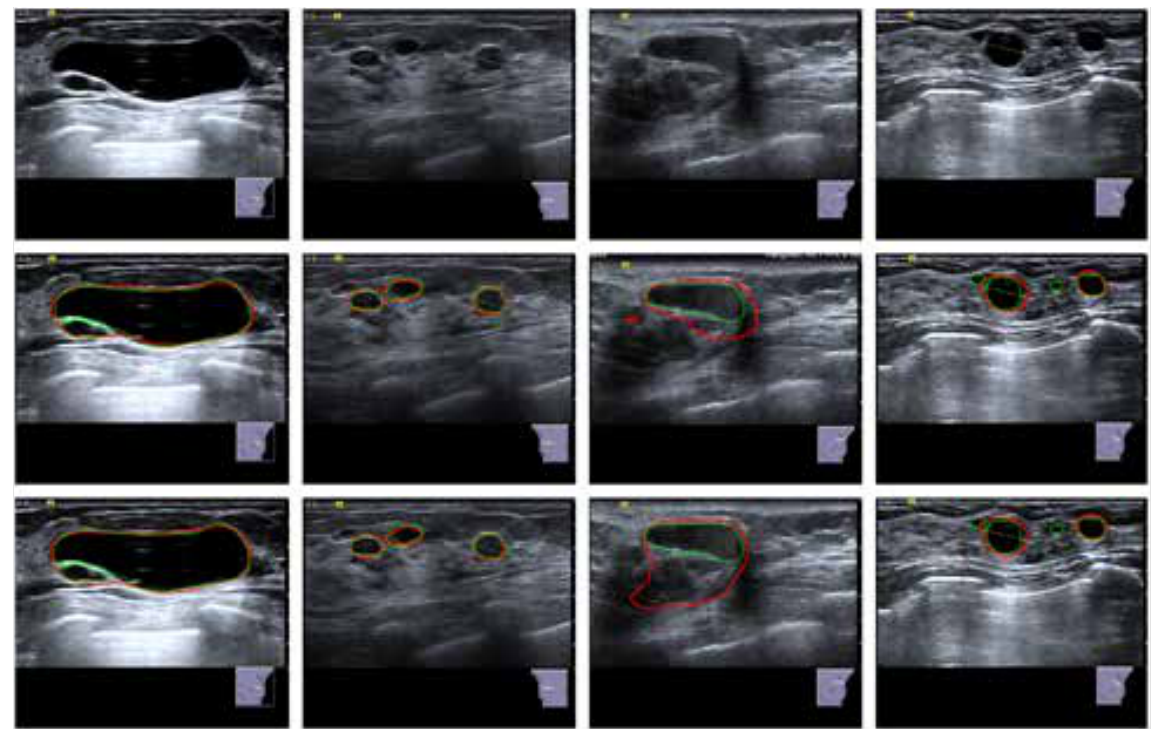
Figure 11 Cases of incorrect segmentation for breast nodule images by the pre-trained convolutional neural network (PCNN) and convolutional neural network without pre-training (NCNN). The original images are shown in the first row; the ground truths are green; the segmentation results of the PCNN and the NCNN are red shown in the second row and in the third row,